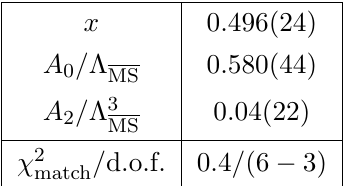
Table 4 . Fitting parameters in Analysis (I). Values inside parentheses denote statistical